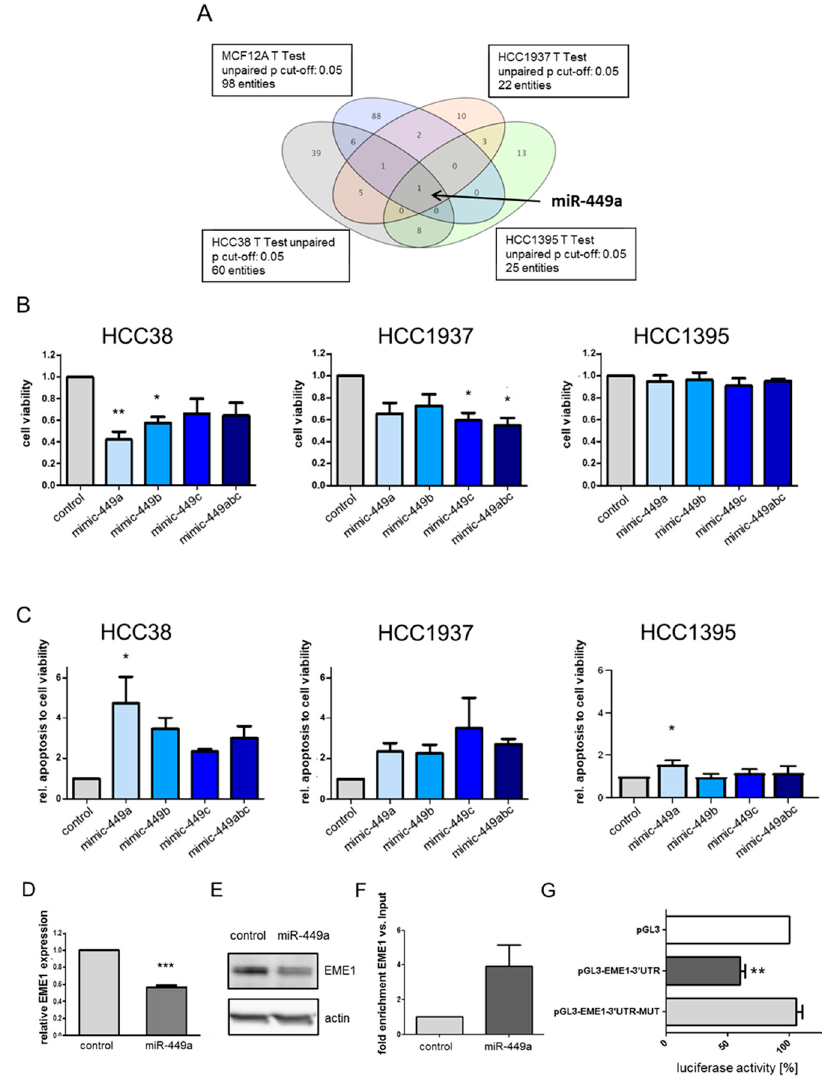
Figure 1. EME1 is a direct target of epigenetically regulated tumor suppressive miR-449a in TNBC cell lines. ( A ) Identification of significantly upregulated miRNAs after TSA treatment for 24 h by intersection using one-way ANOVA followed by Dunnett’s multiple comparison test. p < 0.1; FC ≥ 4. ( B ) Cell viability analyzed by WST-1 assay in TNBC cells transfected with miR-449-mimics normalized to control (Allstars Negative Control) transfected cells. ( C ) Apoptosis analyzed by caspase3/7 activity in TNBC cells transfected with miR-449-mimics normalized to cell viability and the control. Bar graphs show mean ± SD. N = 3, * p < 0.1, ** p < 0.01, *** p < 0.001. ( D ) Expression of EME1 measured by RT-PCR 48 h after transfection with miR-449a-mimics or control. ( E ) Expression of EME1 protein in HCC38 cells using Western blotting. Actin was used as a loading control on the same blot but on a different part of the gel. ( F ) Ago2 immunoprecipitation was performed and the enrichment of EME1 vs input was detected by RT-PCR. ( G ) Firefly luciferase activity measurements in HEK293 cells of miRNA-mimics in relation to renilla luciferase activity. 3 (cid:48) UTR: untranslated region of EME1, 3 (cid:48) UTR-MUT: untranslated region of EME1 with mutations in the predicted target site for miR-449a. Bar graphs show mean ± SD ** p < 0.01, *** p < 0.001, 2-tailed Student’s t -test for ( D ), one-way ANOVA/Dunnett’s multiple comparison test for ( B , C